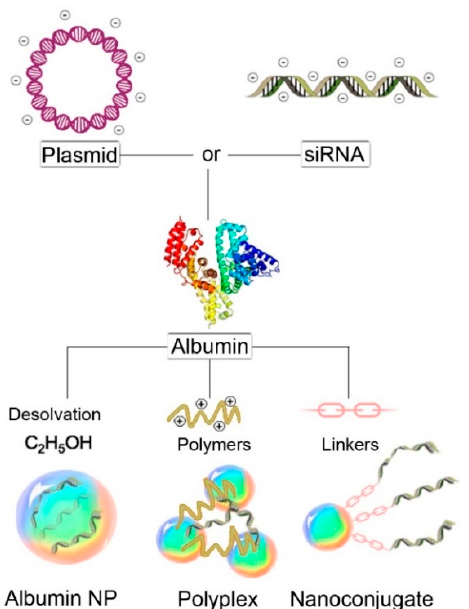
Figure 2. Schematic representation of different albumin nanocarriers for gene